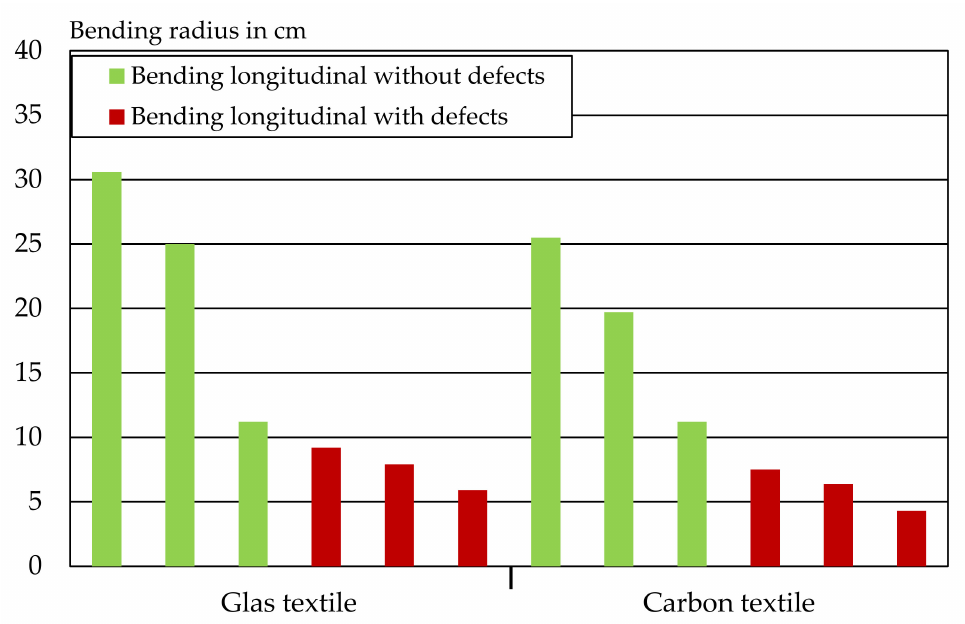
Figure 12. Bending radius for extruded and subsequently longitudinally shaped glass and carbon TRM